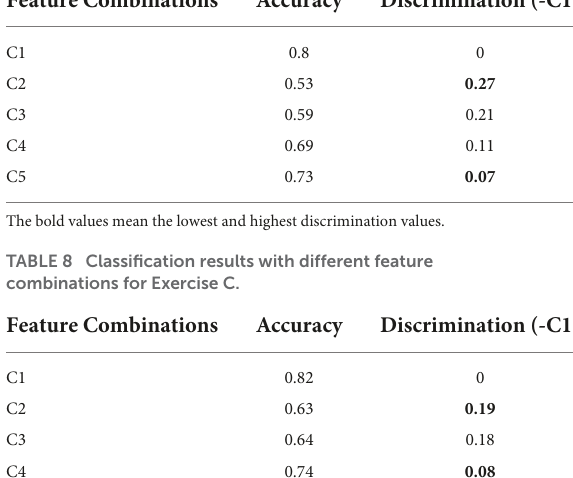
TABLE 7 Classification results with different feature combinations for Exercise B. Feature Combinations